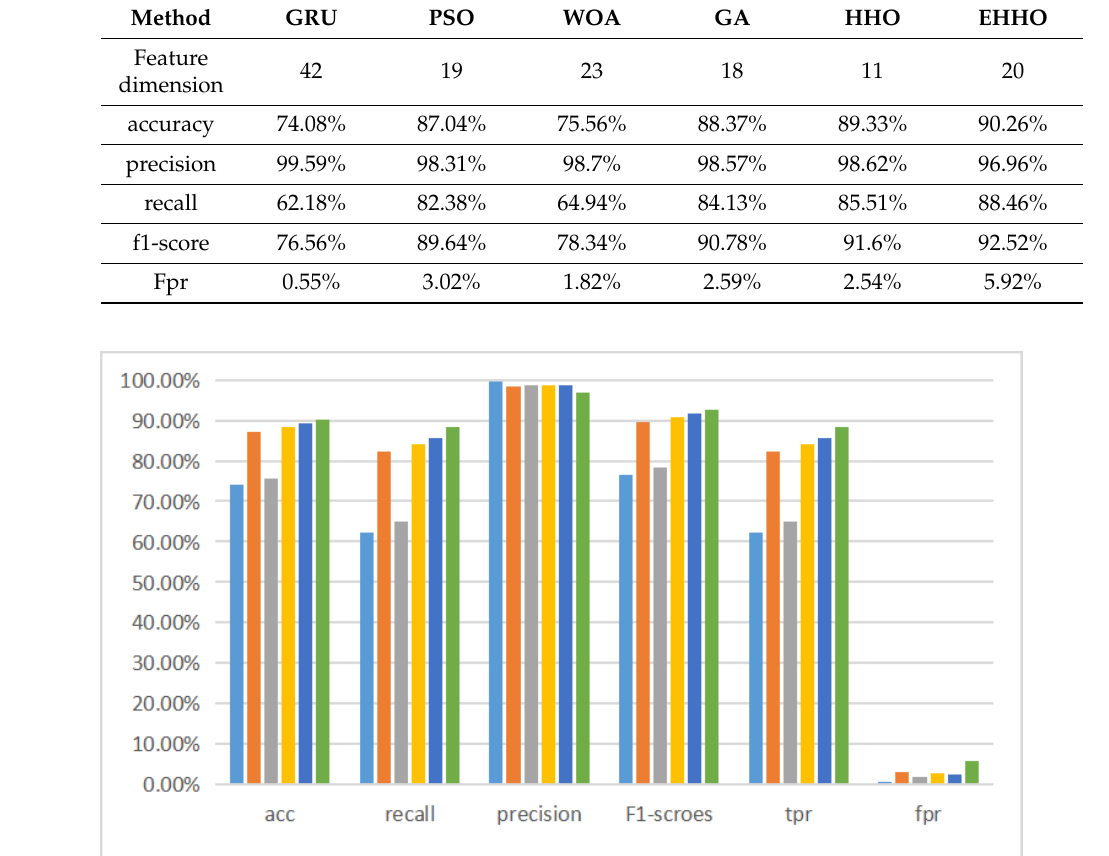
Table 9. The results of the UNSW-NB15 binary classification experiment.